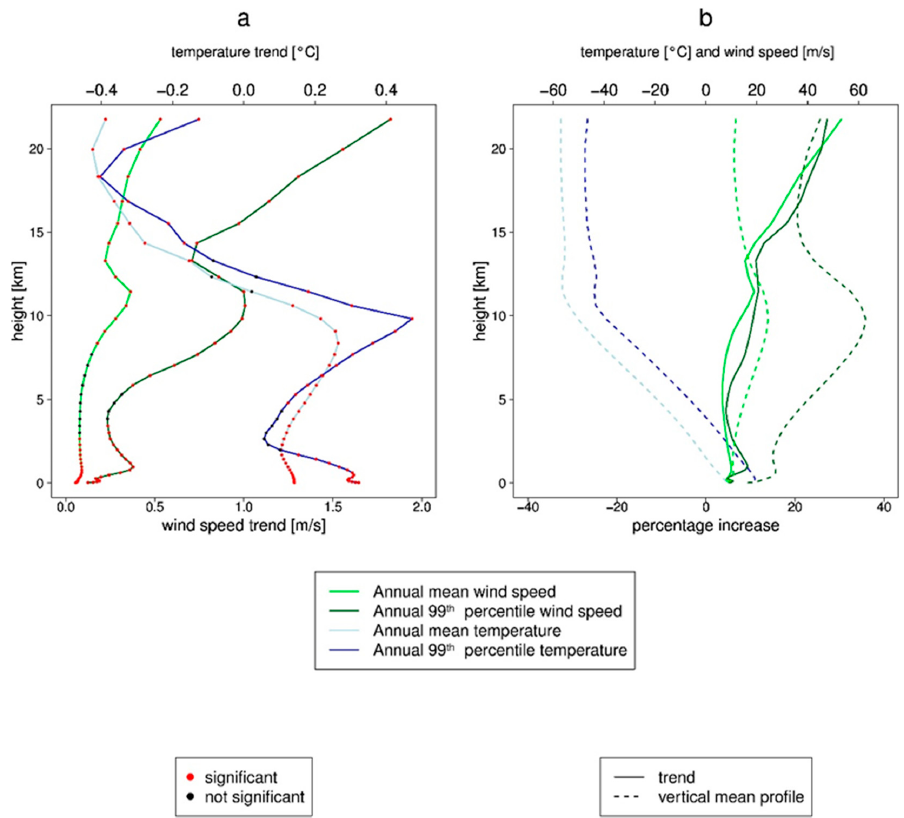
Figure 5. ( a ) GB0028 trends of the domain mean and annual mean (light colors) or annual 99th percentile (strong colors) wind speed (green) and temperature (blue) for all 40 model levels. Every dot represents a model layer, a red dot shows that the trend is significant, and a black dot indicates a non-significant trend. ( b ) GB0028 percentage increase of wind speed and temperature of the domain mean and annual mean (light colors) or annual 99th percentile (strong colors) for all 40 model levels (solid lines) and the domain mean and 67 years mean wind speed and temperature (light colors) or 67 years mean of annual 99th percentile (strong colors) (dotted lines).